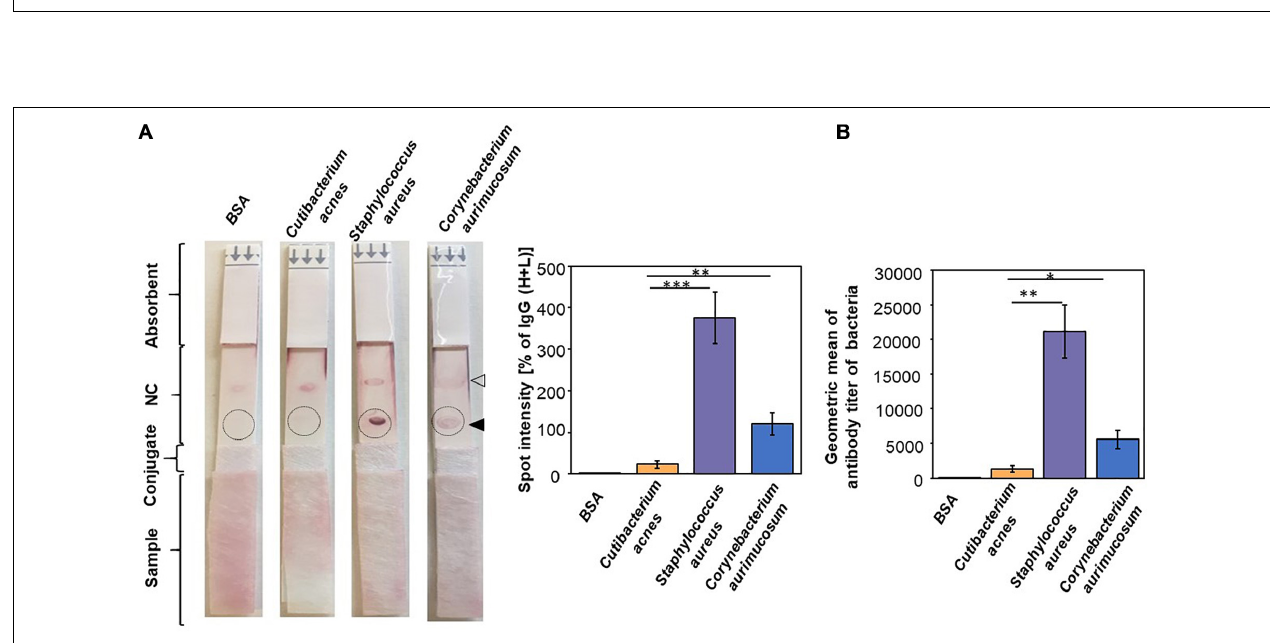
FIGURE 2 | Production of a higher titer of antibodies to S. aureus and C. aurimucosum than C. acnes in human sera. (A) BSA or the lysate of C. acnes , S. aureus , or C. aurimucosum (3 µ g) was on the test line (solid triangle) of an NC membrane of an LFIA. The anti–human IgG (H+L) was spotted on the control line (open triangle) of an NC membrane of each LFIA. After adding human sera (5%, 200 µ L) onto sample pads, the relative intensities of purple spots (circles) were quantified by normalizing those of IgG (H+L) spots. (B) The antibodies (IgG) to C. acnes , S. aureus , or C. aurimucosum were detected by adding human sera to 96-well microplates coated with lysates of C. acnes , S. aureus , or C. aurimucosum , respectively. Quantitative antibodies were measured by using the endpoint of diluted sera producing the same OD 570 - 450 as a 1/100 dilution of sera added to the BSA-coated wells. Individual, not pooled, sera from three human subjects were used for detection of antibodies on LFIAs and 96-well microplates. Sera used for LFIAs and 96-well microplates were from the same human subject. p < 0.05 ( ∗ ), p < 0.01 ( ∗∗ ), and p < 0.001 ( ∗∗∗ ) with mean ± SD were obtained from three independent experiments.